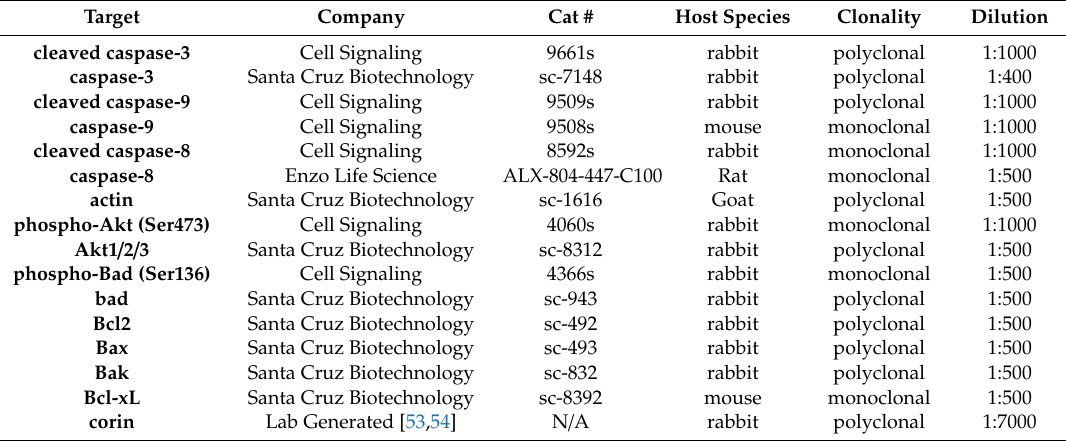
Table 1. Antibody